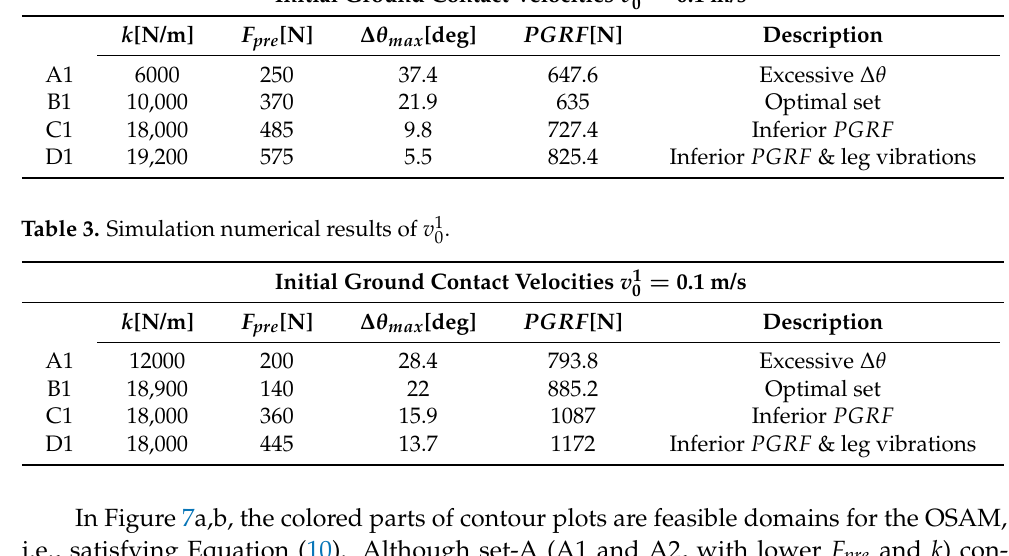
Table 2. Simulation numerical results of v 1